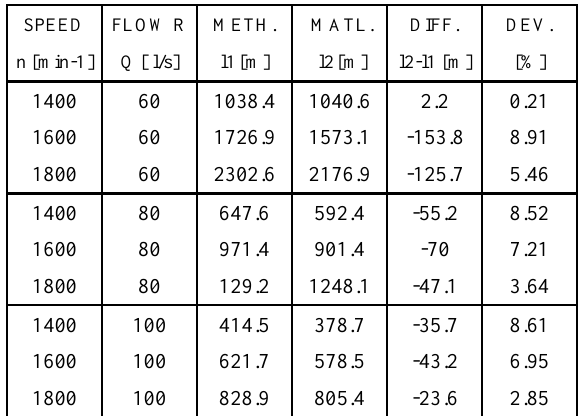
Table 1. Maximal pipe length determined